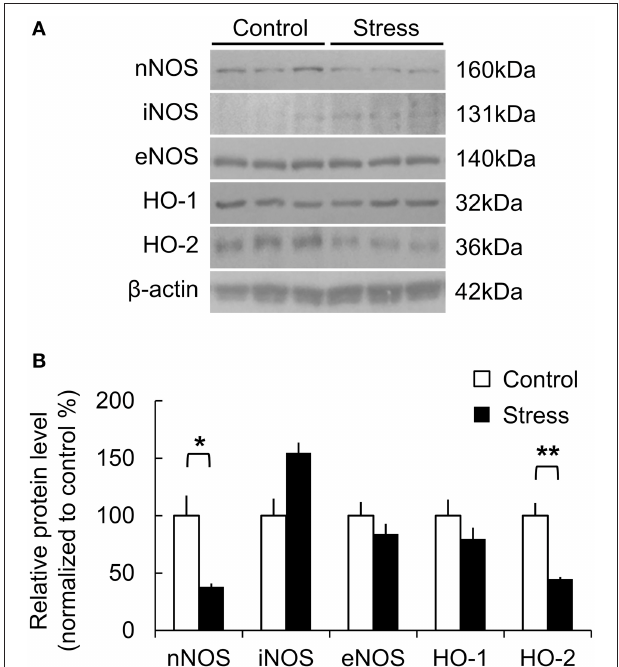
FIGURE 4 | Protein expression related to vasomodulation in the somatosensory cortex of control and 3-week stress groups. (A,B) Changes in expression of NO- and CO-producing enzymes. The western blot band intensity was normalized to the control by densitometry [nNOS, neuronal nitric oxide synthase; iNOS, inflammatory nitric oxide synthase; eNOS, endothelial nitric oxide synthase; HO-1, Heme oxygenase-1; HO-2, Heme oxygenase-2, Control ( n ) = 3 and Stress ( n ) = 3, Independent t -test, * p < 0.05 ; ** p < 0.01